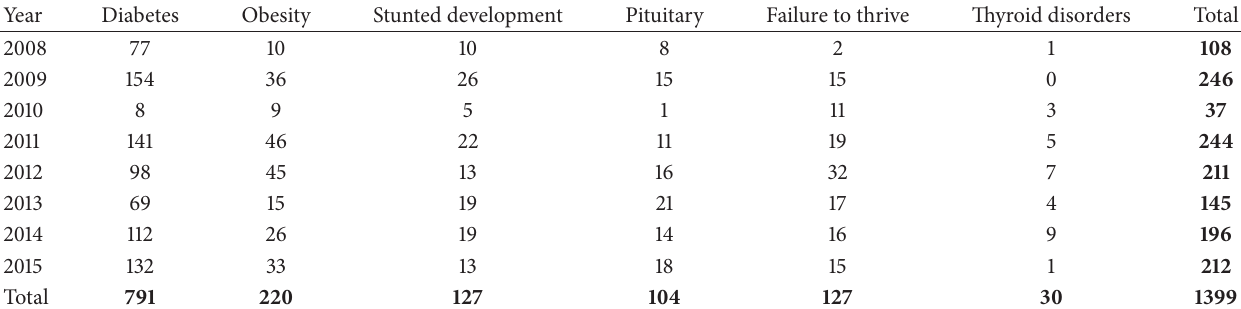
Table 2: Number of patients screened and treated during the PETCA fellowship from 2008 to